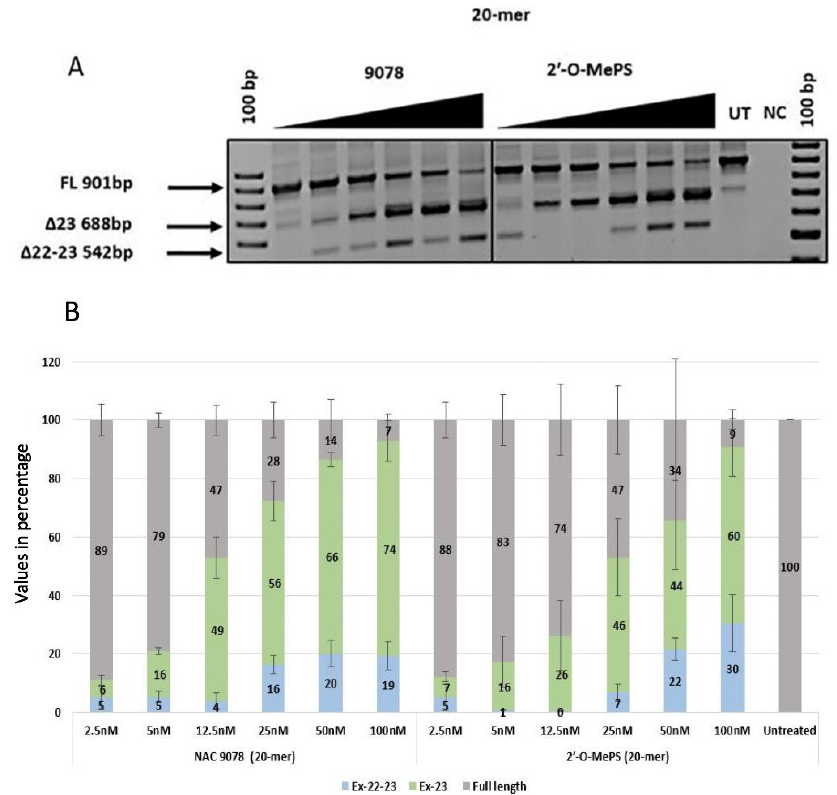
Figure 2. ( A ) RT-PCR analysis of exon-23 skipping induced by antisense oligonucleotides (AO) NAC 9078 and the corresponding 2 (cid:48) -OMePS control AO in H2K mdx mouse myotubes (gel image A corresponds to one of the three gels used for data in ( B )); ( B ) densitometry analysis of exon-23 skipping induced by AO NAC 9078 and the corresponding 2 (cid:48) -OMePS control AO (triplicates) in H2K mdx mouse myotubes. Concentration range 2.5–100 nM. Grey, full-length product exon 20–26; green, exon-23 skipped product; blue, dual exon 22 / 23 skipped product; UT, untreated; NC, negative control (Error bars represent the standard deviation of